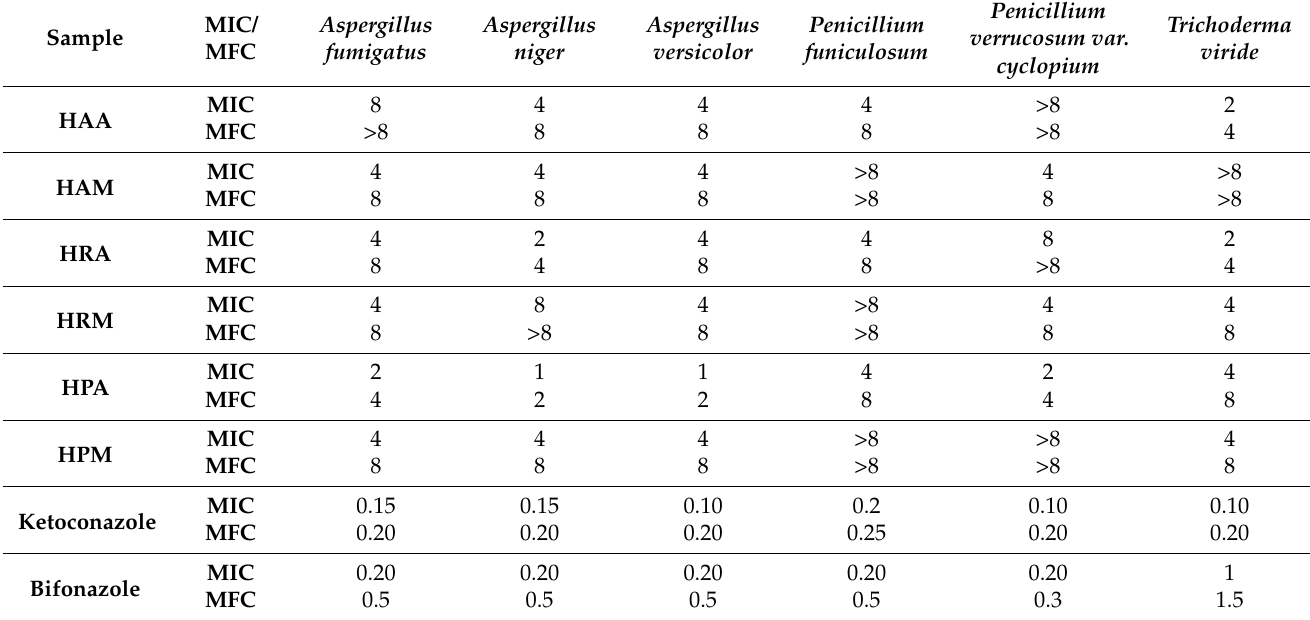
Table 5. Antimicrobial and antifungal activities of Hypericum extracts. Ketoconazole and bifonazole were used as positive control for fungus growth. The results were given as minimum inhibitory concentration (MIC) and minimum fungicidal concentration (MFC) (all expressed as